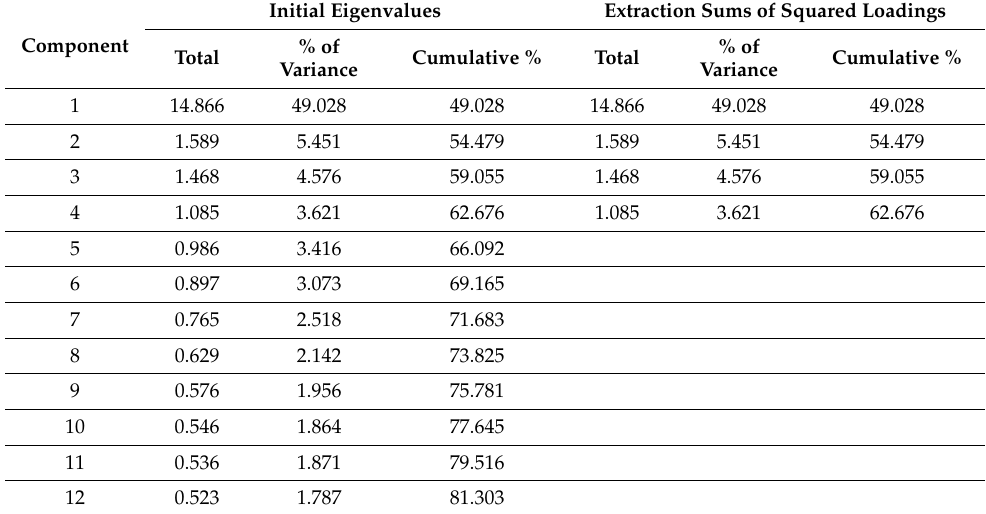
Table A3. Harman’s single factor